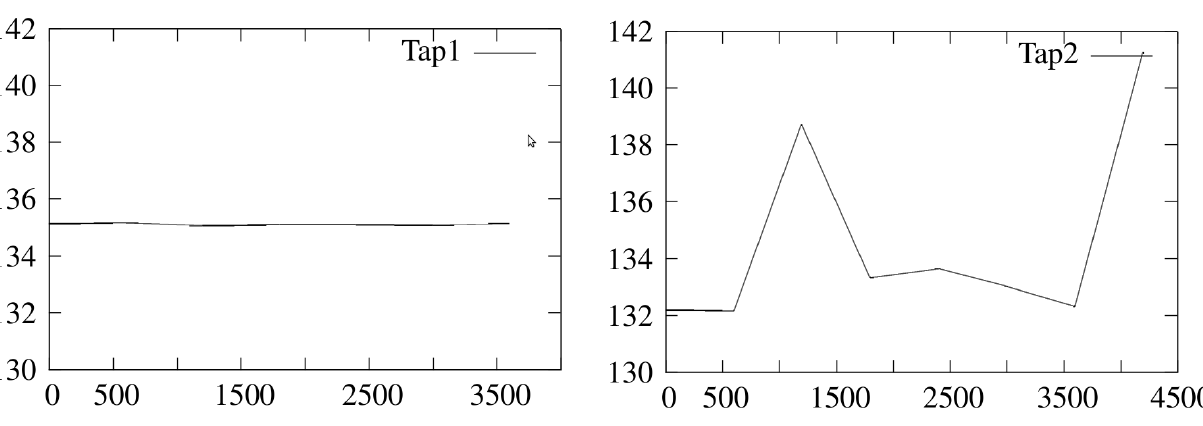
Figure 2. Average packet sizes for the 600 s slices of packet capture from Tap1 and